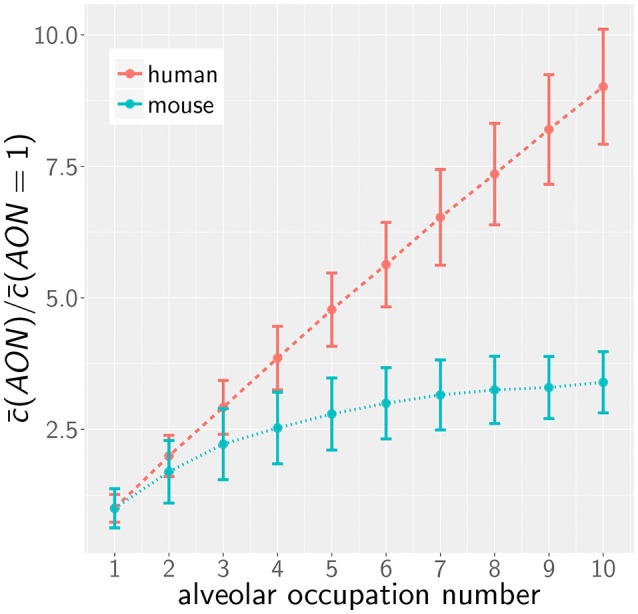
Mean of the normalized alveolar chemokine concentration as a function of the AON in mice and men obtained from simulations. Error bars represent the standard deviation of this measurement.